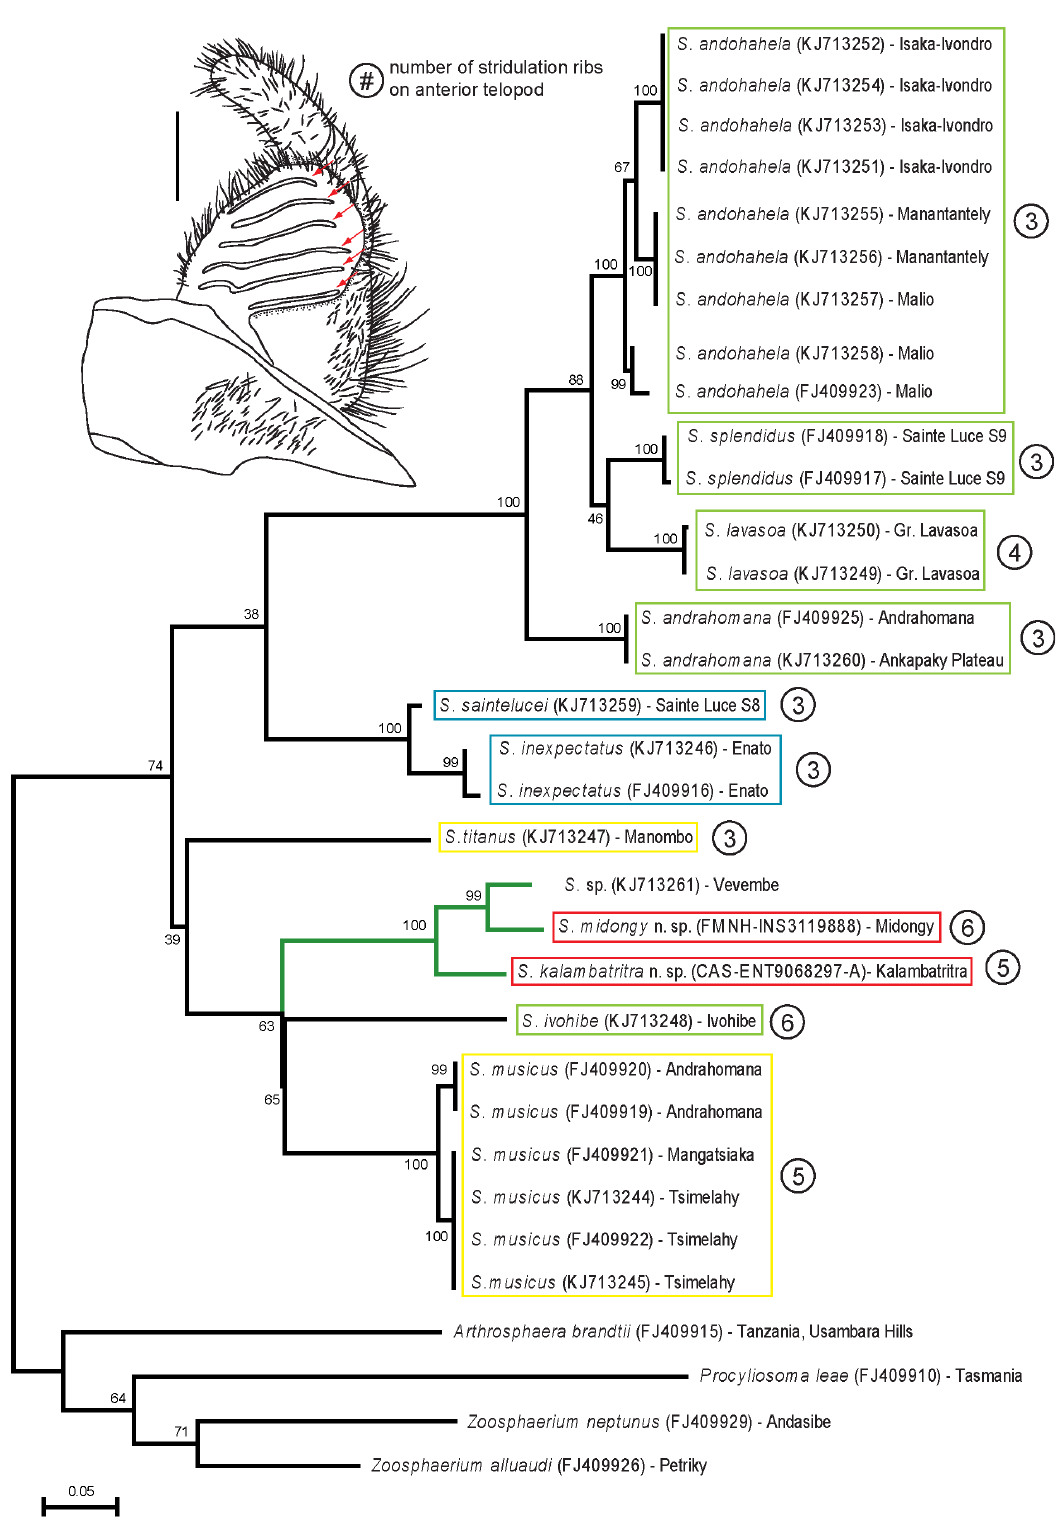
Fig. 10. Maximum likelihood tree based on the COI sequence after 1000 bootstrap replicates under the GTR+G+I model. Branch length indicates genetic distance. Numbers on branches indicate bootstrap support. Schematic drawing shows right anterior telopod of Sphaeromimus midongy sp. nov. Numbers in circles indicate number of stridulation ribs on the male